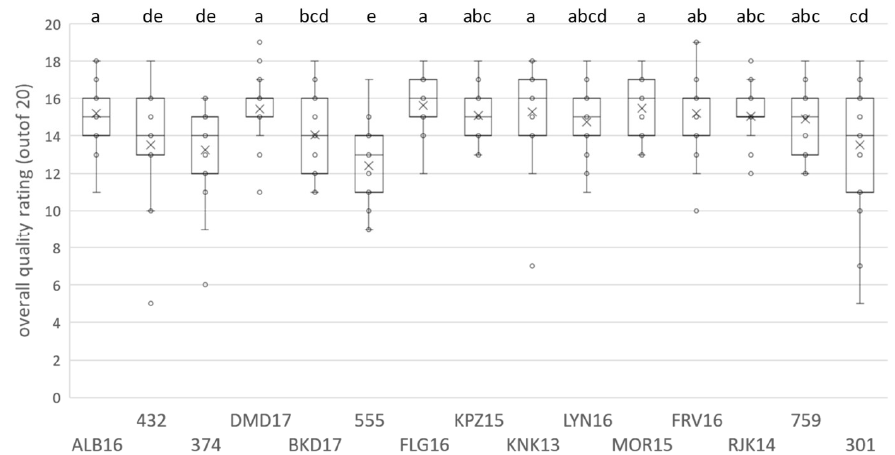
Figure 1. Box-and-whiskers plot illustrating the analysis of variance (ANOVA) results obtained for the overall quality rating for the Pinotage wines evaluated, including individual rating and mean marker. Letters indicate significant differences ( p < 0.05). The codes are as specified in the text.